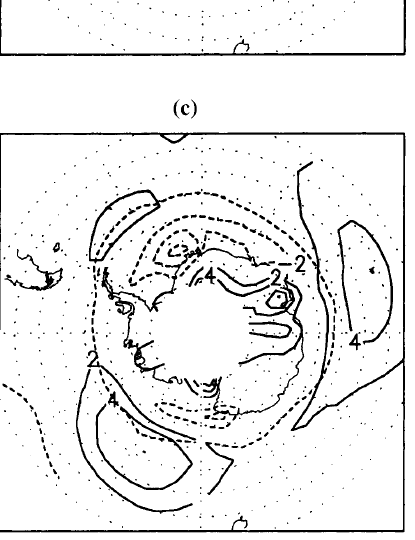
Fig. 5a–c. Mean winter anomalies (NOICE minus control): a changes in temperature at the model’s lowest sigma level, every 5 (cid:176) C. b Changes in sensible heat flux, every 30 Wm ) 2 . c Changes in mean sea level pressure, every 2 hPa. The zero contours are not shown. The dashed line around Antarctica indicates the mean sea-ice extent for winter in the control simulation. The northern latitude is 40